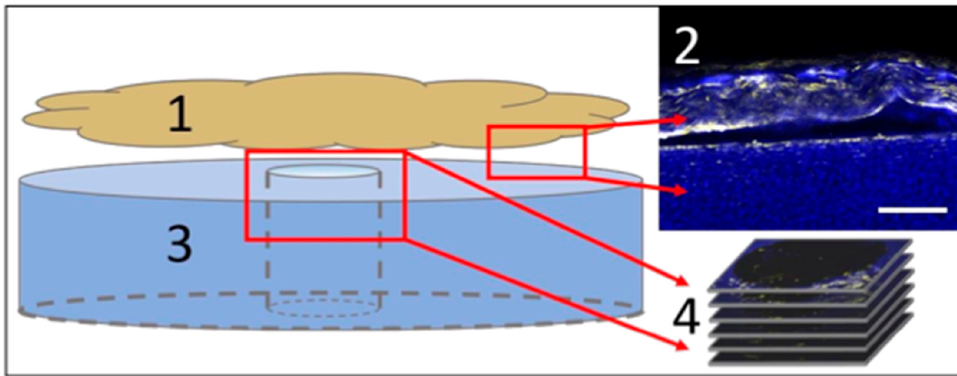
Figure 4. Experimental set ‐ up of cartilage ‐ synovium defect ‐ repair model. DiI ‐ labeled synovium (1, yellow) was placed in direct apposition (2) with DAPI ‐ labeled cartilage (3, blue). Synovium was removed for confocal z ‐ stack imaging (4), leaving the DiI ‐ stained FLS on cartilage specimen. Migra ‐ tion of FLS were monitored through the depth of the cartilage defect annulus. Scale bar = 100 μ